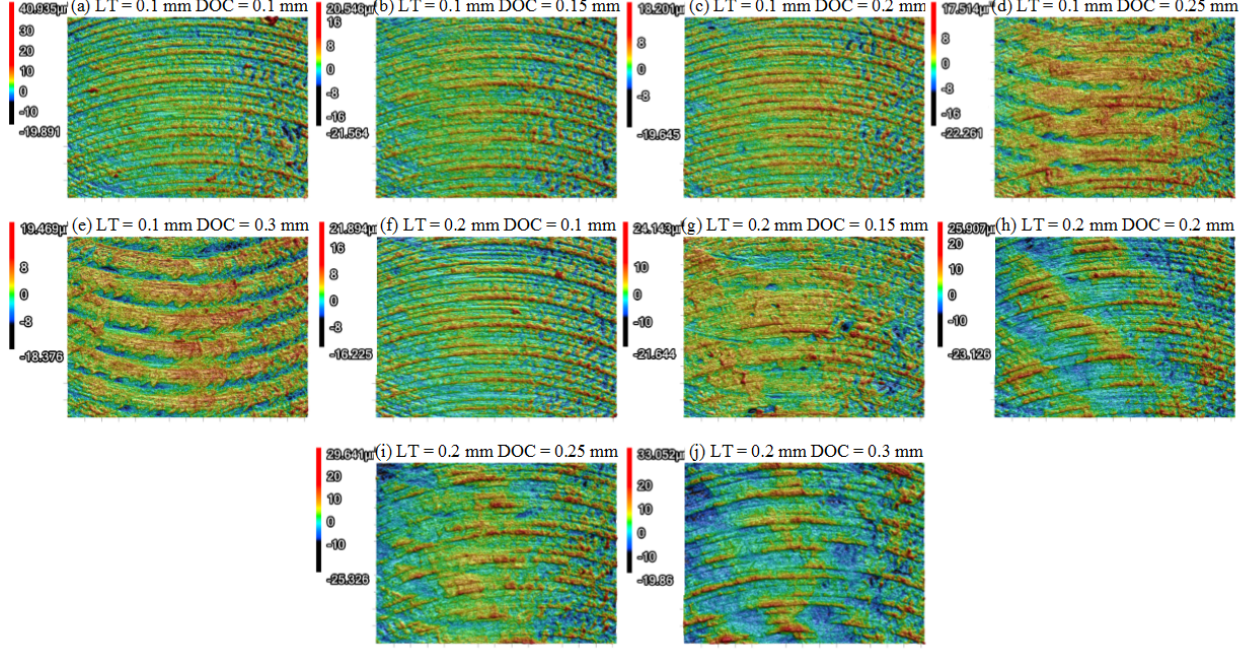
Figure 9. 3D morphologies comparison (RA = +45 ° / − 45 ° , SS = 3000 r/min, FRT = 0.04 mm): ( a ) LT = 0.1 mm, DOC = 0.1 mm; ( b ) LT = 0.1 mm, DOC = 0.15 mm; ( c ) LT = 0.1 mm, DOC = 0.2 mm; ( d ) LT = 0.1 mm, DOC = 0.25 mm; ( e ) LT = 0.1 mm, DOC = 0.3 mm; ( f ) LT = 0.1 mm, DOC = 0.1 mm; ( g ) LT = 0.1 mm, DOC = 0.15 mm; ( h ) LT = 0.1 mm, DOC = 0.2 mm; ( i ) LT = 0.1 mm, DOC = 0.25 mm; ( j ) LT = 0.1 mm, DOC = 0.3 mm.